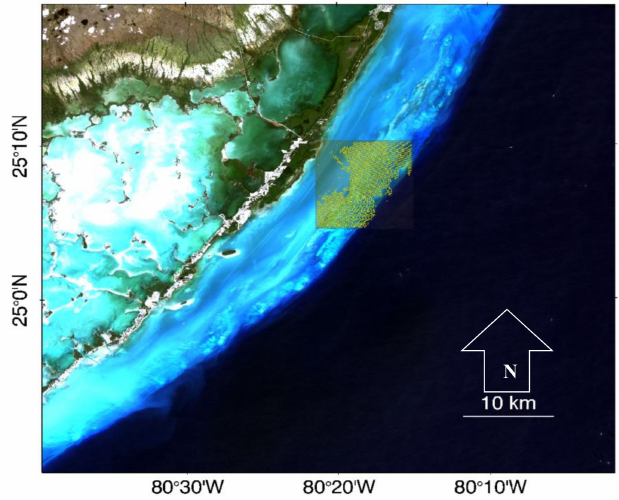
Figure 1. Landsat 8 image showing the upper Florida Keys. Bathymetric LiDAR data used for validation are shown in